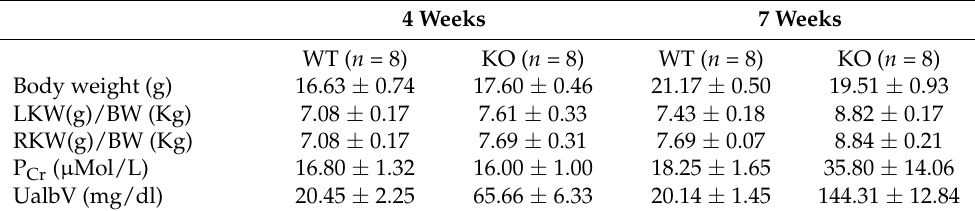
Table 1. Clinical characteristic for Alport and wild-type mice.